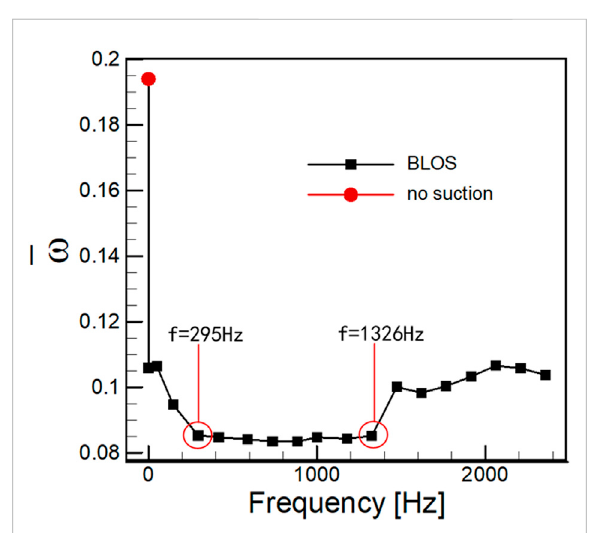
Δ m s = 82.91%, BLOS.